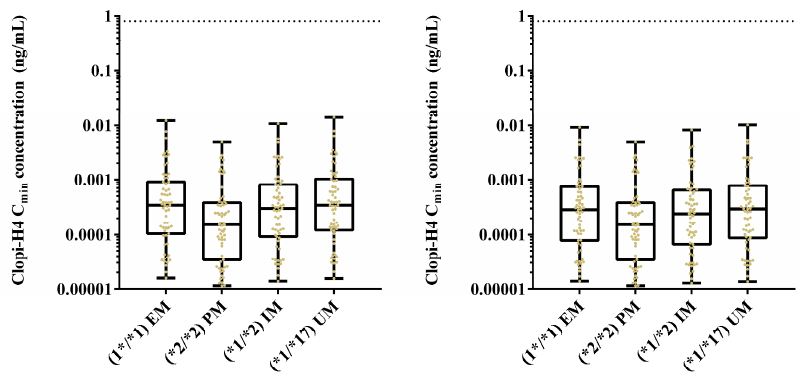
Figure 12. Impact of clopidogrel standard dose regimens on final dose clopi-H4 plasma C max (upper panels) and C min (lower panels) in Chinese subjects under scenarios where mean hepatic CYP2C19 abundance is increased (left panels) or decreased (right panels) by 30%. All subjects are demarked for either all EM, PM, IM or UM populations. Box and whisker plots represent maximum, 75th percentile, median, 25th percentile and minimum clopi-H4 C max . All subjects ( n = 100 for each phenotype) received a loading dose of 300 mg on day 1, followed by daily doses of 75 mg for four days. Dashed horizontal lines represent the lower therapeutic limit for clopi-H4.